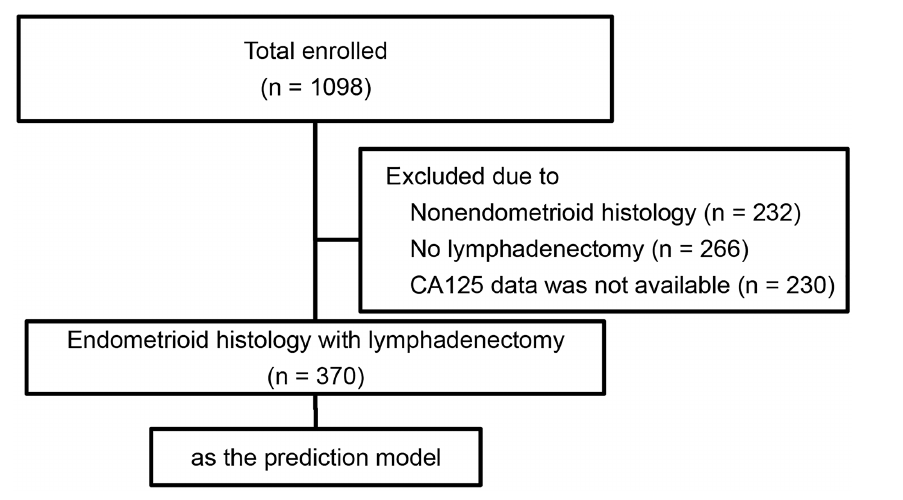
Fig 1. Flowchart of selection of patients in prediction